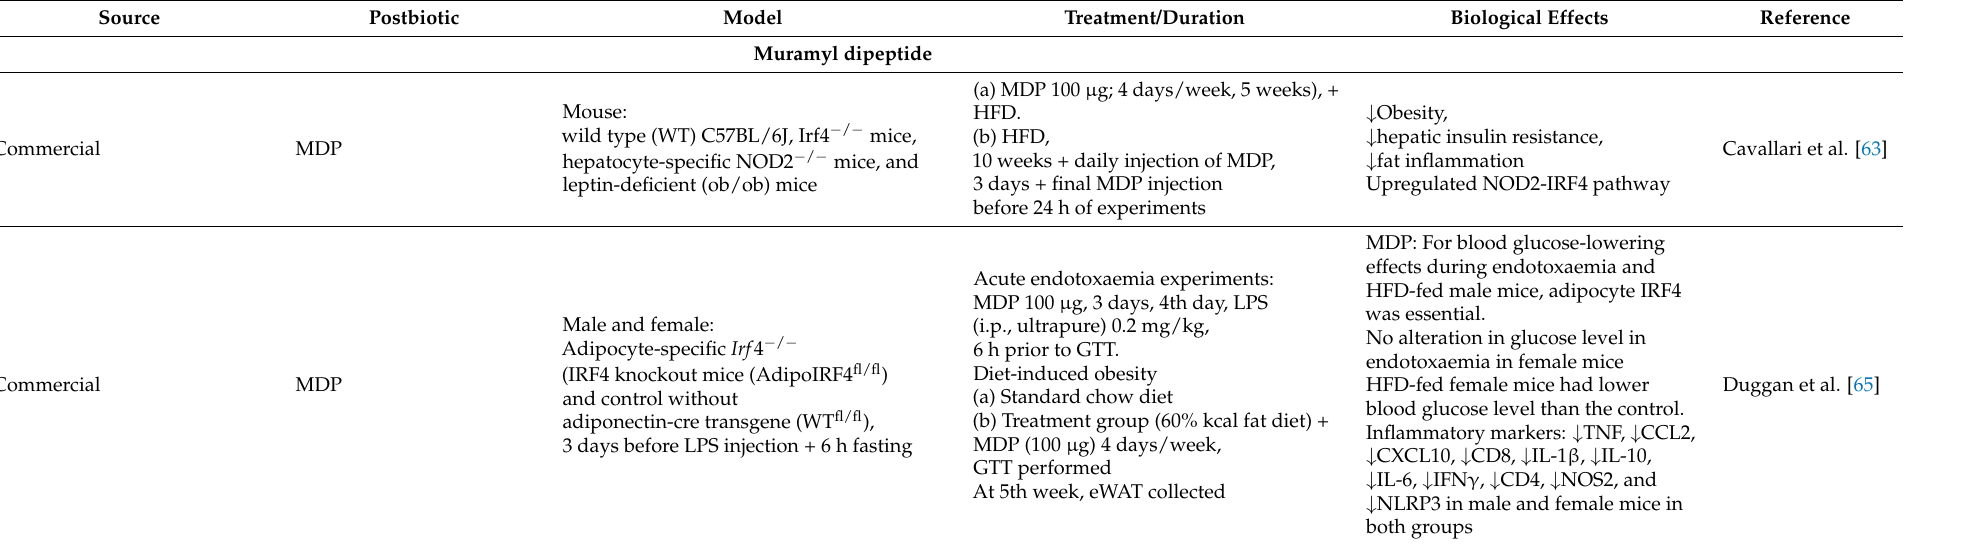
Table 1. Effects of postbiotics on obesity parameters: in vitro and in vivo